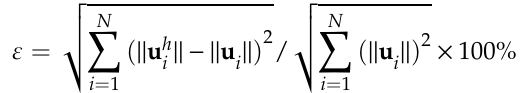
Table 1. Errors of displacement solutions (pendulum) calculated from different algorithms.